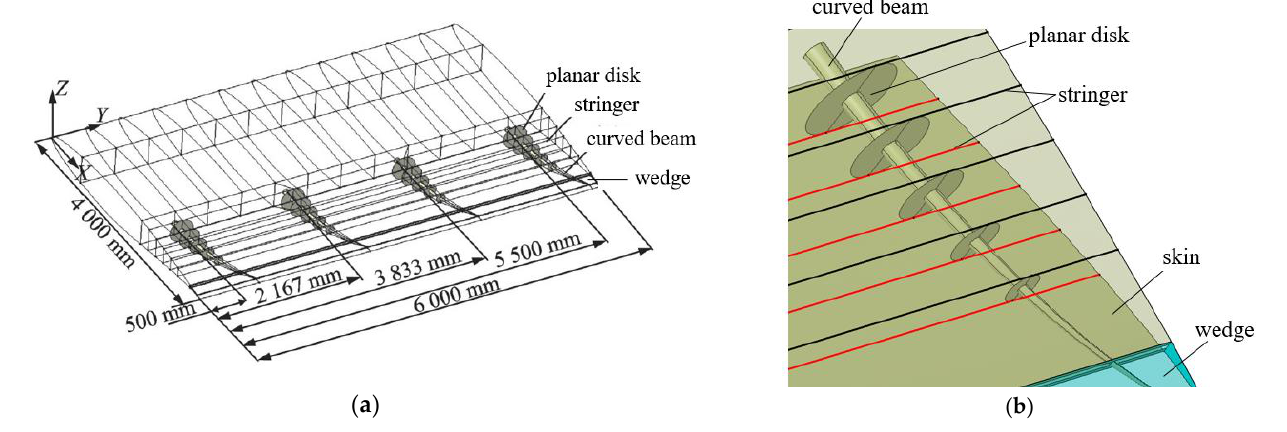
Figure 1. Rectangular wing structure model: ( a ) whole model; ( b ) local model. A two-cell wing structure of a small UAV is taken as an example in this paper. The inner segment is rectangular and the outer segment is trapezoidal. The plane shape of the semi-wing is shown in Figure 2. The proportional deflection of the wing root and wing tip is performed only on the trailing edge of the outer segment